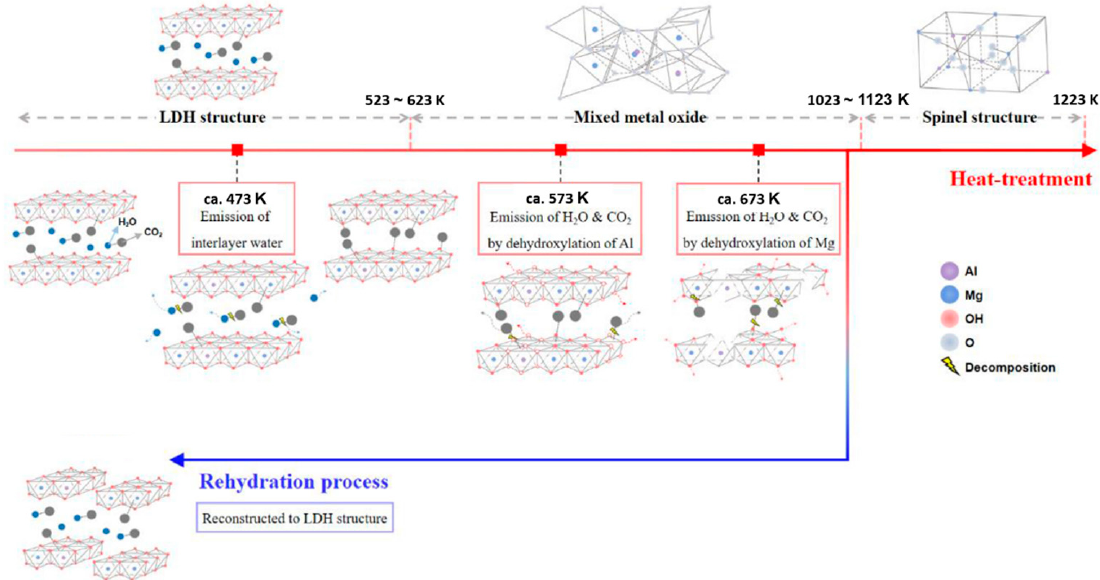
Figure 6. Schematic illustration of the structural changes in Mg–Al hydrotalcite during heat treatment and rehydration. Reprinted and modified with permission from ref. [85]. Copyright 2021 Else- vier.